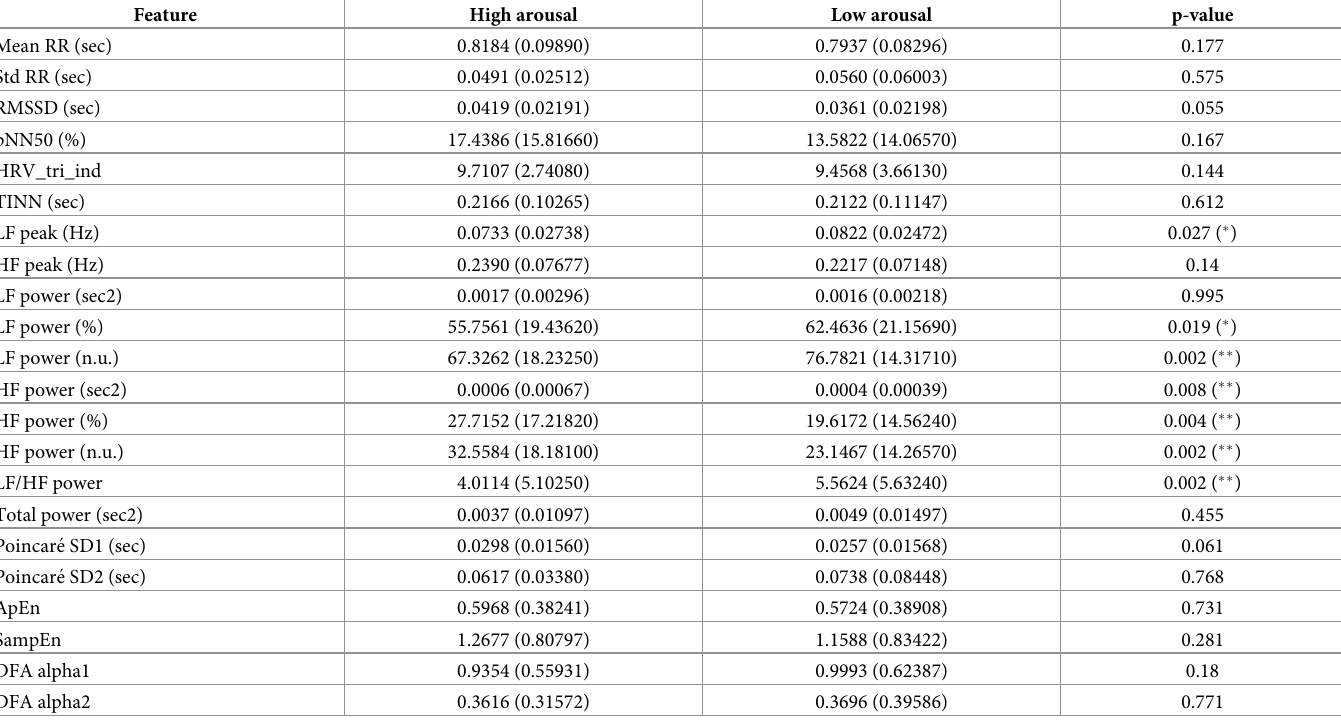
anced in TPR (67.24%) and TNR (76.74%). The model has a score of 0.439 for Cohen’s kappa . Table 2. HRV responses in the real museum in terms of arousal